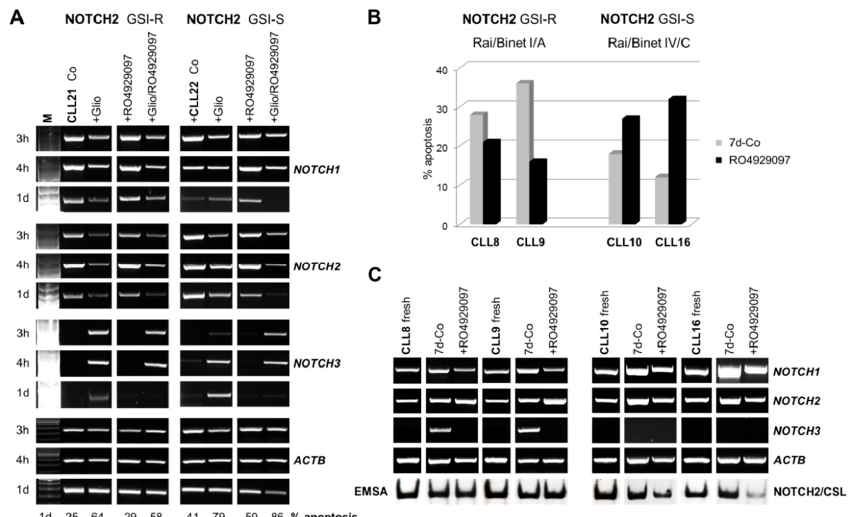
Figure 3. RO4929097 inhibited gliotoxin-induced and basal NOTCH3 mRNA expression in CLL